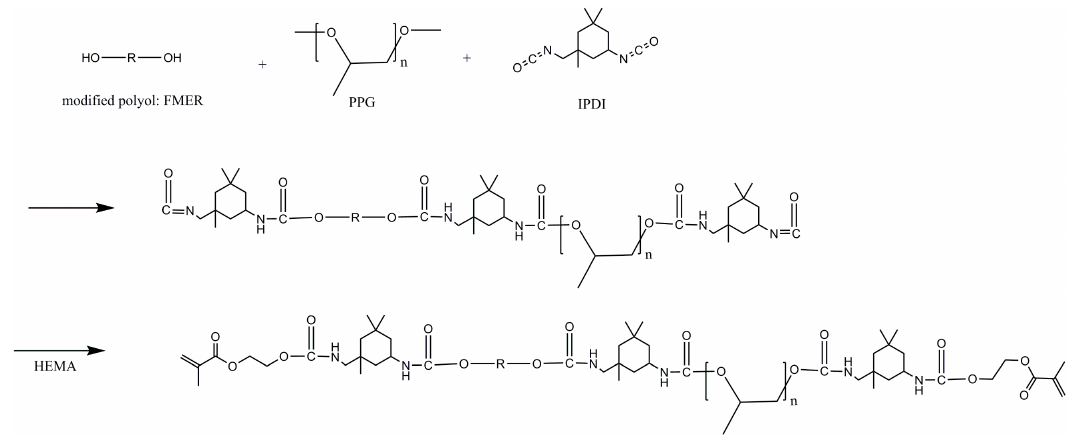
Figure 1. Reaction scheme of the fatty acid-modified epoxy resin to synthesize the polyol.